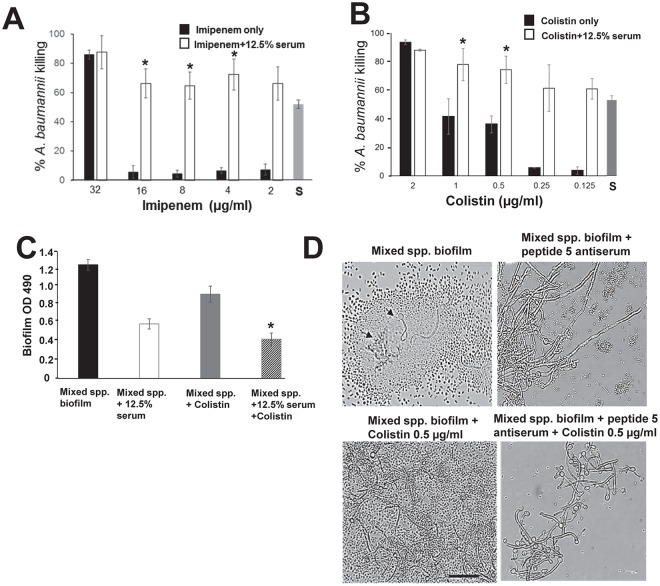
Anti-peptide 5 serum is synergistic with antimicrobials, against biofilms.A. baumannii were grown in the presence of imipenem (2–32 μg/ml, x axis) without anti-peptide 5 serum (black bars) or in combination with 12.5% of the anti-peptide 5 serum (white bars) (A). The same assay was performed with different concentrations of colistin (0.125–2 μg/ml) (B). S in the A and B denotes 12.5% anti-peptide 5 serum only. *P <0.02 vs. S. Mixed species biofilms were treated with 0.5 μg colistin, 12.5% serum or a combination of colistin and serum. Metabolic activity of the biofilm cells was measured by the XTT assay (OD 490 nm) (C). *P <0.05 vs. all other three conditions. Mixed species biofilm architecture under the four conditions in panel C were visualized by light microscopy (D).